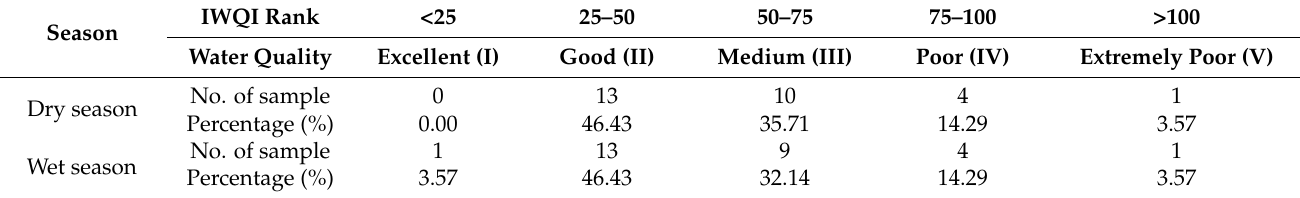
Table 2. Evaluation results of self-organizing water quality evaluation method at different